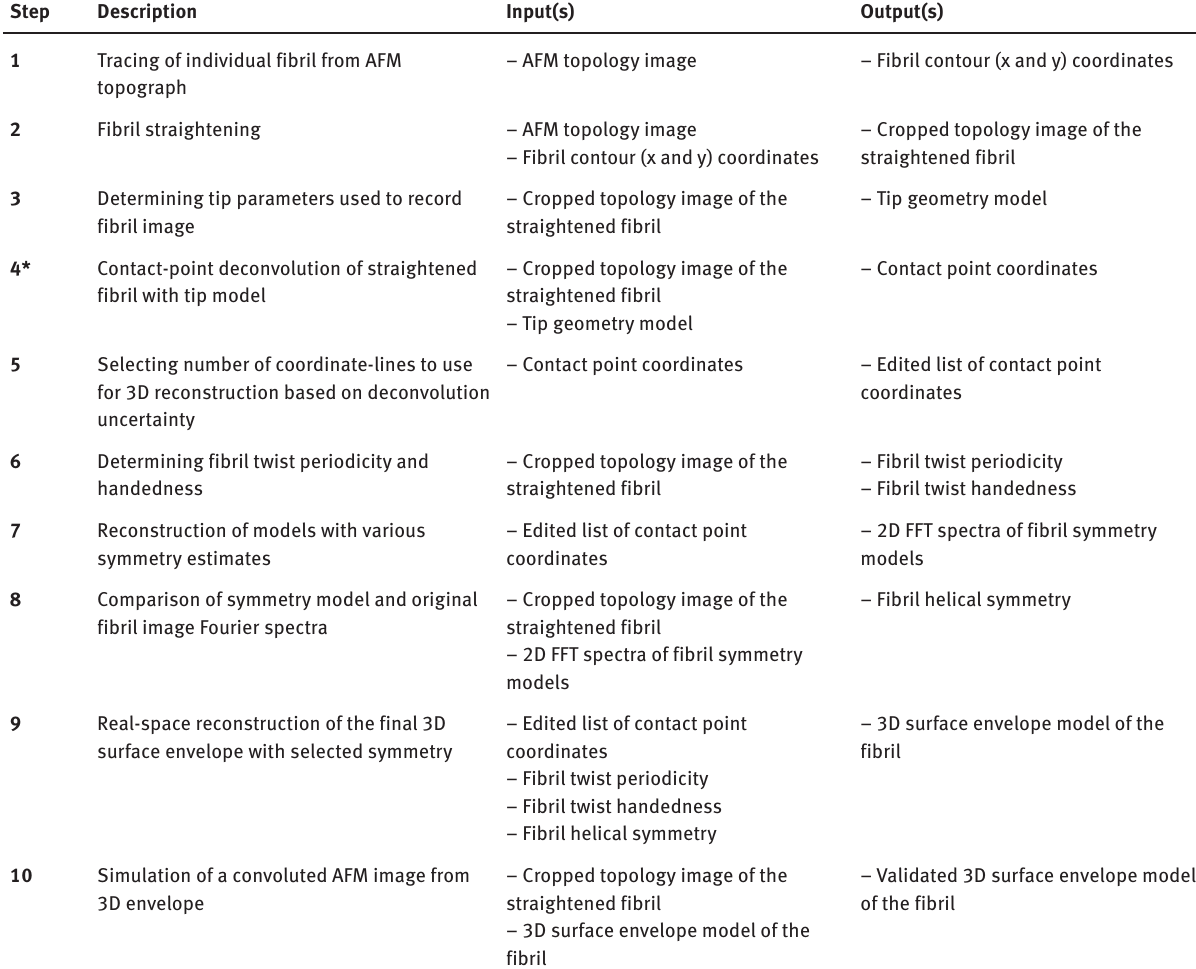
Table 1: Workflow flow chart of AFM topograph processing and 3D helical fibril surface envelope